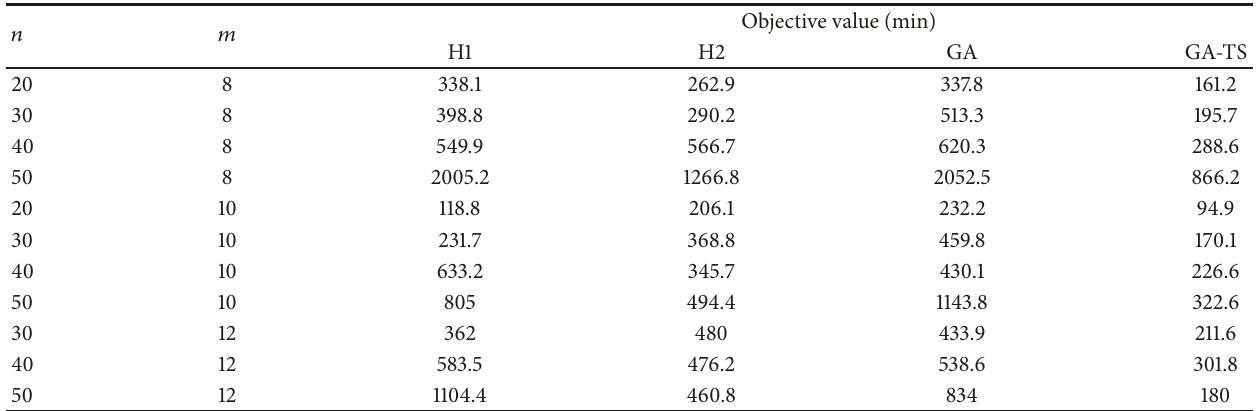
Table 5: Test results in large-sized